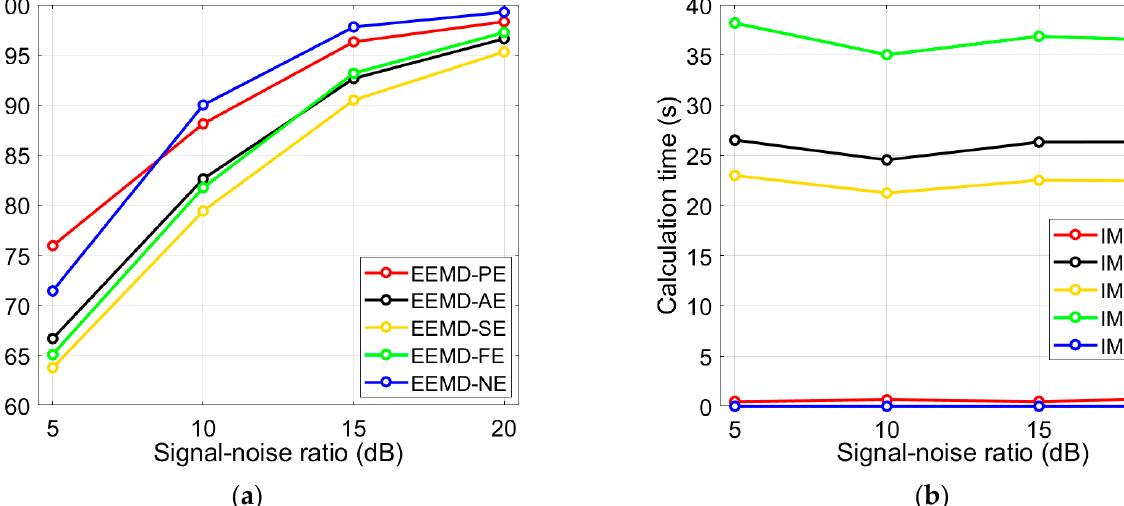
Figure 9. Comparation of di ff erent methods to highlight PE. ( a ) Comparation of average diagnostic accuracy; ( b ) Comparation of calculation time.